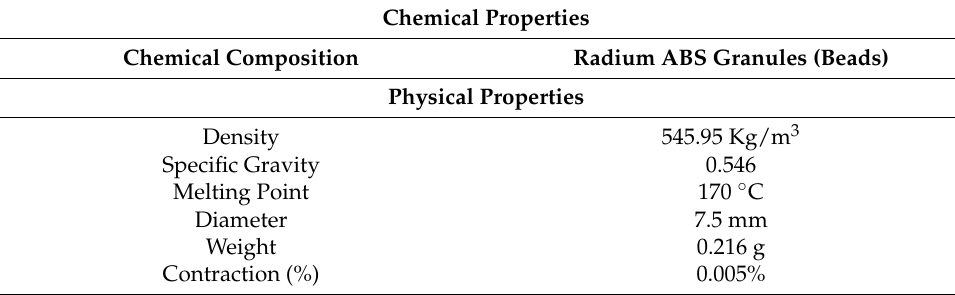
Table 3. Physical and chemical properties of radium